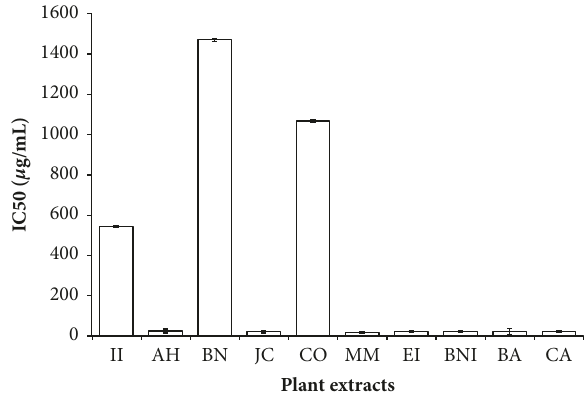
Figure 4: DPPH free radical scavenging activity of selected plant extracts used in the management of oral and skin infections in southeast folklore medicine of Nigeria. II, Ipomoea involucrata ; AH, Acalypha hispida ; BN, Breynia nivosa ; JC, Jatropha curcas ; CO, Chromolaena odorata ; MM, Macrolobium macrophyllum ; EI, Eleusine indica ; BNI, Baphia nitida ; BA, Burkea africana ; CA, Cassia alata .